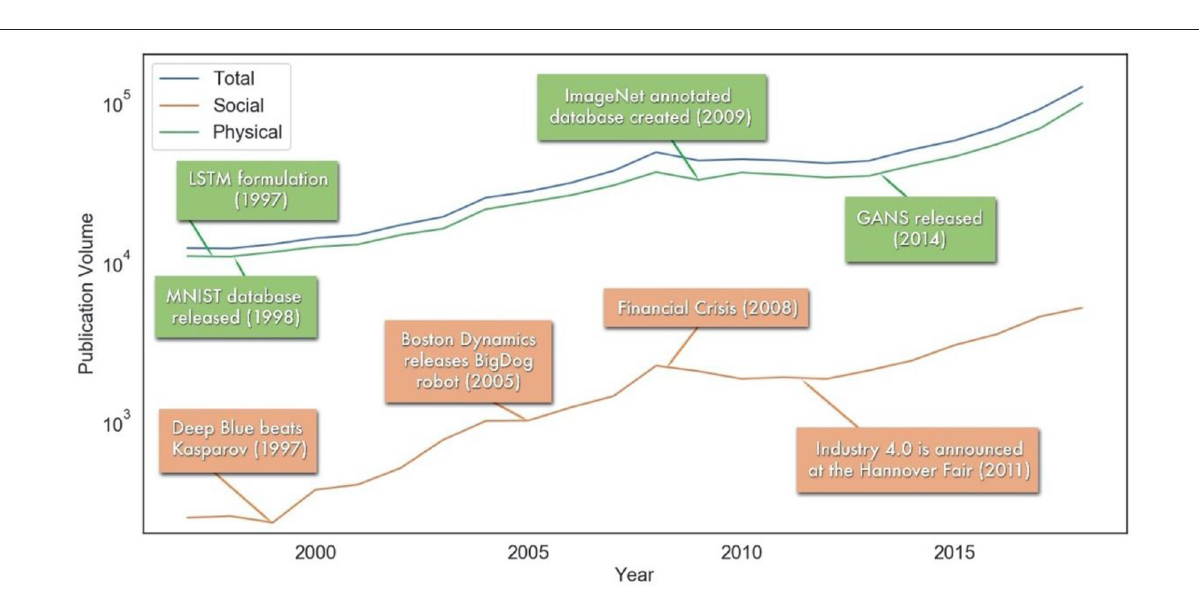
FIGURE 10 | Several selected milestones related to the technical and social domains, correlating the events with the overall annual trends of the domains